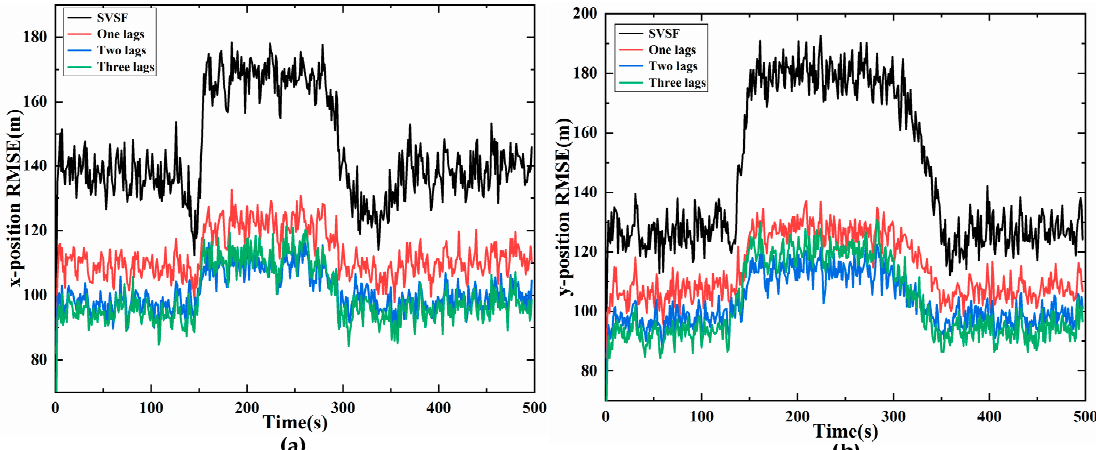
Figure 7. SVSF smoother of different lags compare (a) position RMSE on x- axis; (b) position RMSE on y-axis.